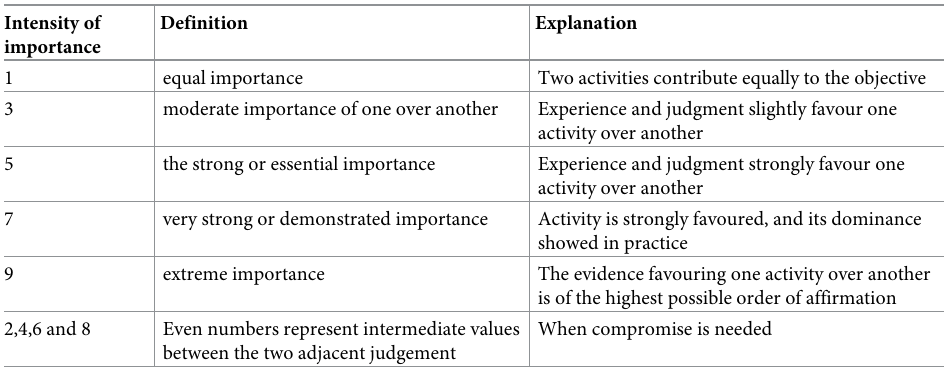
Microsoft Excel. Table 3 shows a pairwise comparison matrix for the research.